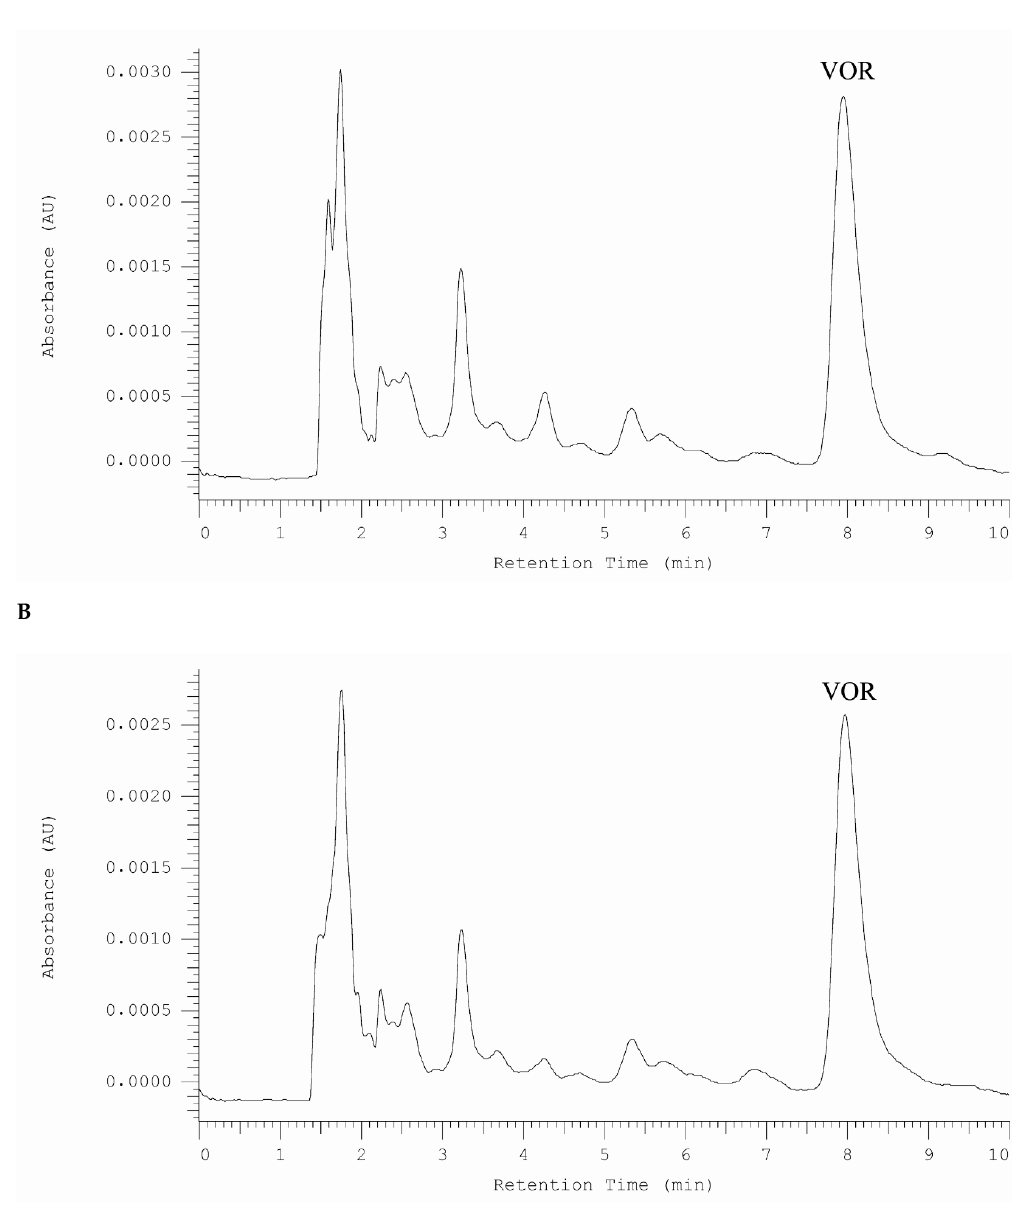
Figure 4. HPLC-DAD chromatogram obtained for saliva sample from patient treated by vortioxetine. The sample was taken ( A ). 1 h and ( B ). 24 h after drug administration.